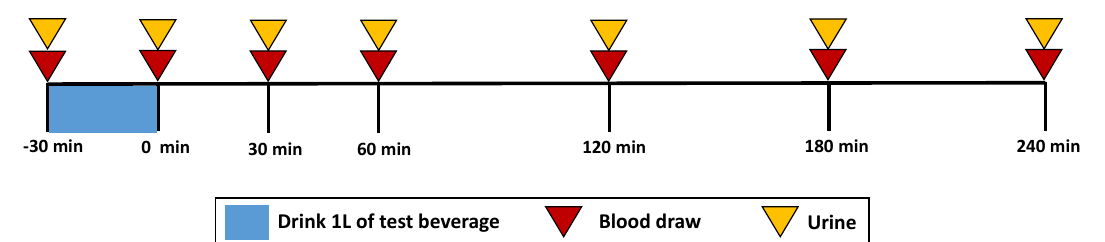
Figure 1. Timeline of measurements. Blood samples were collected immediately before ( − 30 min) and after (0 min) consuming the final beverage aliquot and at 30, 60, 120, 180, and 240 min post-ingestion. Urine samples were collected following each blood sample except at the 30 min time point, i.e., at 0, 60, 120, 180, and 240 min post-ingestion.